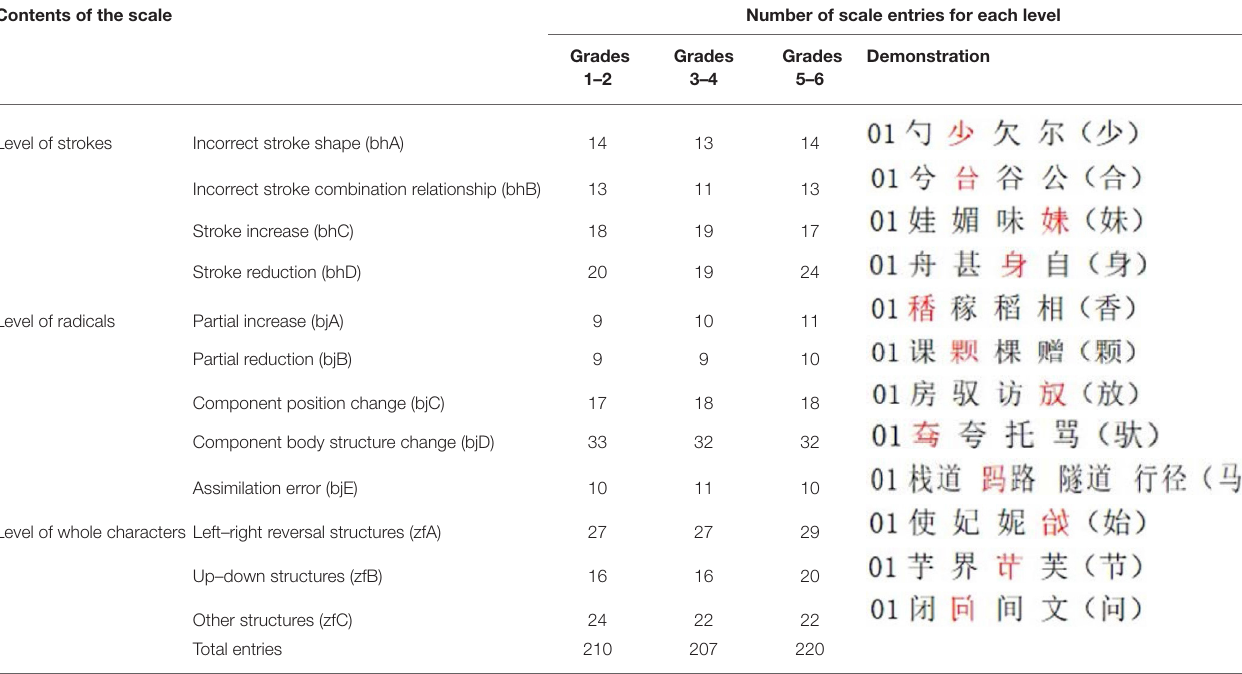
TABLE 2 | Contents in the item pool of the orthographic knowledge scale for children aged 6–12